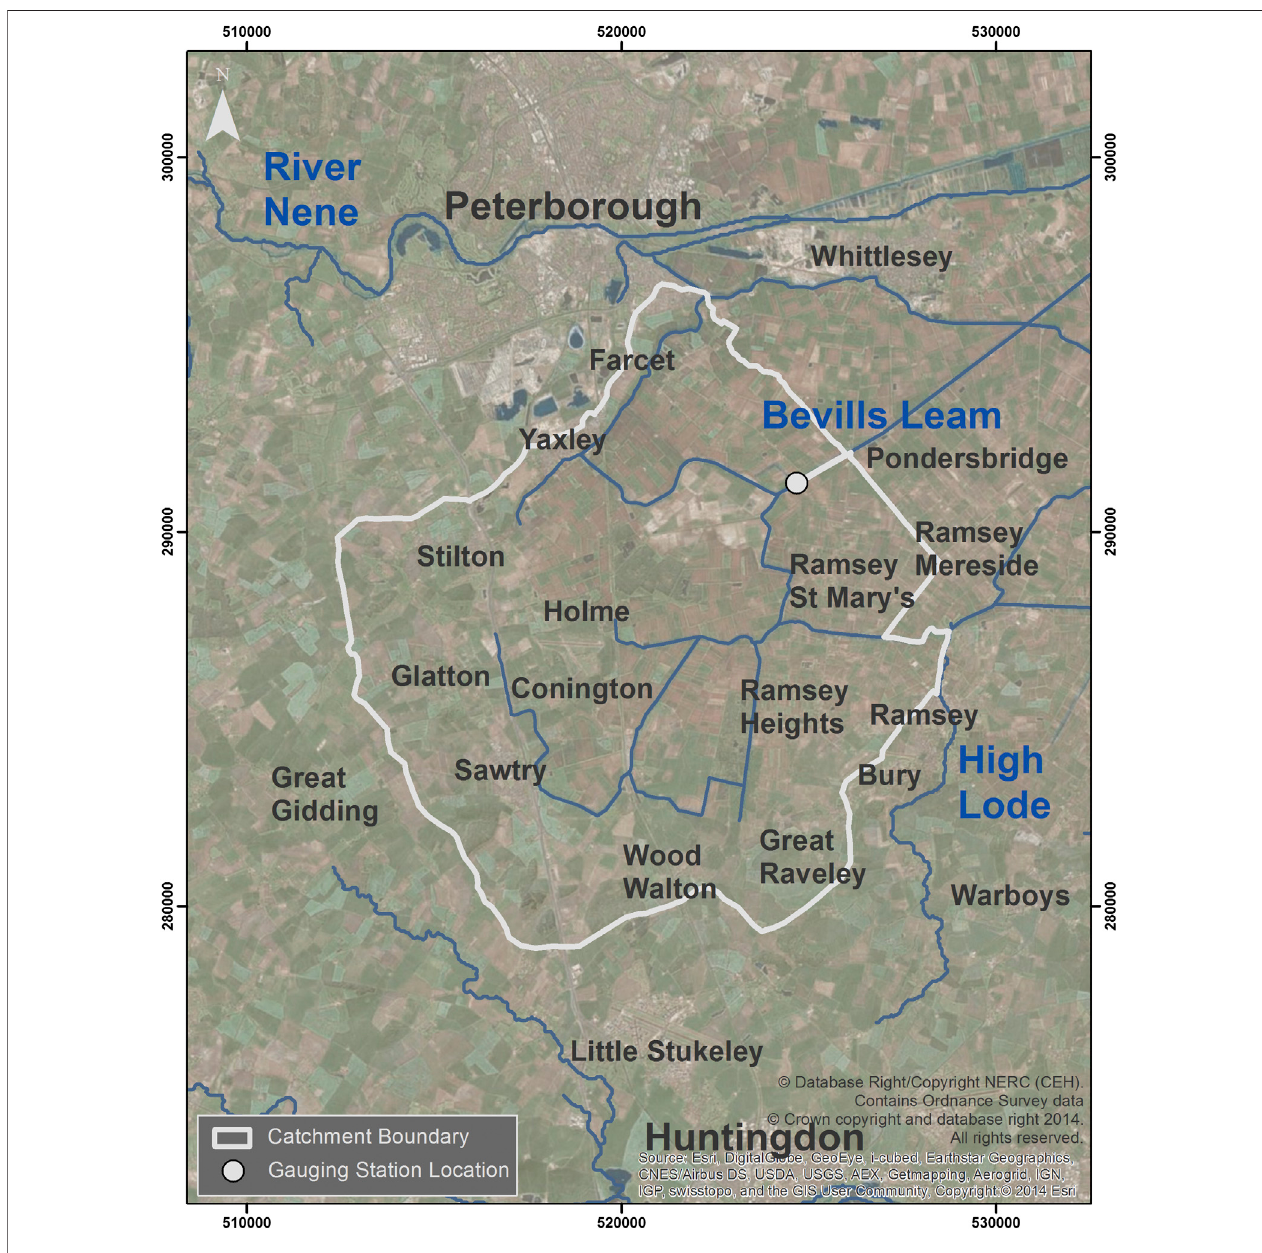
FIGURE 4 | Bevills Leam catchment